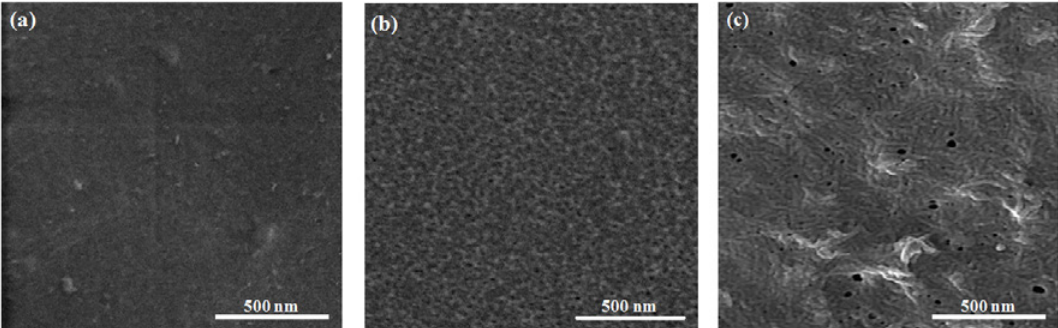
Fig. 3. Surface FE-SEM images of prepared membranes: (a) CA, (b) CA/ND (0.5 wt.%), (c) CA/ND-PEG (0.5